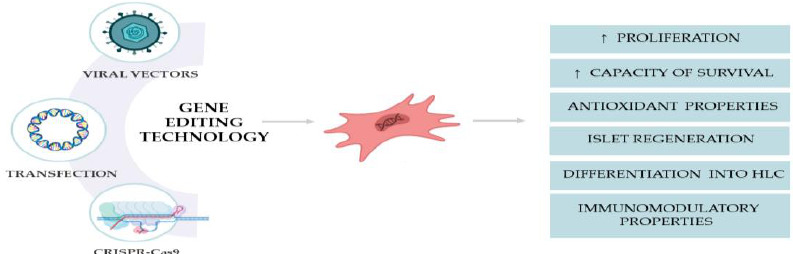
Figure 2. The genetic modification of ADMSCs increases their therapeutic potential by enhancing important characteristics such as proliferation or immunomodulation. Abbreviation: HLCs, hepato- cyte-like cells. hepatocyte-like